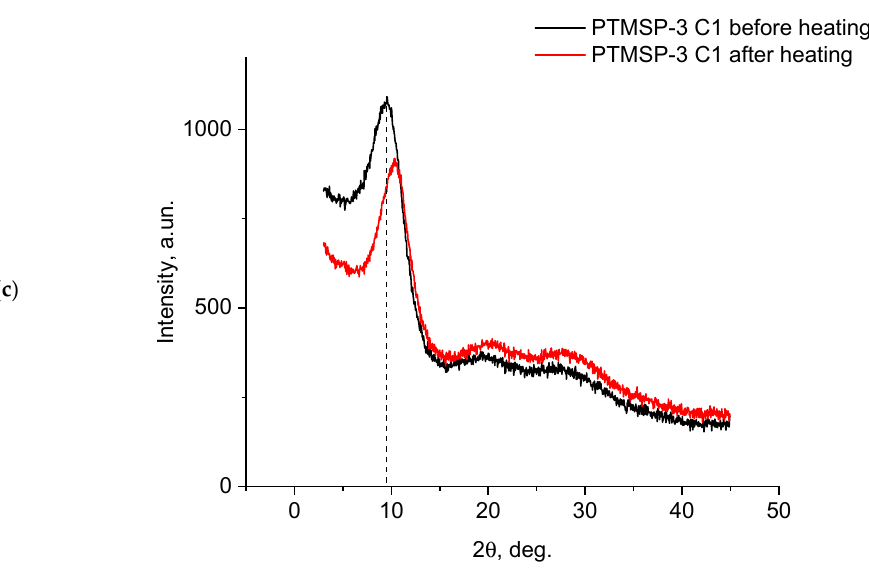
Figure 7. X-ray curves for the PTMSP samples containing stabilizer Irganox 1010, before and after heat treatment (140 ◦ C, 50 h). ( a ) PTMSP-1; ( b ) PTMSP-2; ( c ) PTMSP-3.